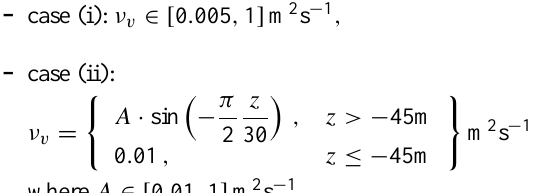
FIG. 2: Time series of the vertical velocity component w at the four indicated (inset in panel b) near-shore midpoints at 30 m depth in the homogeneous rectangular basin of constant depth subject to constant wind from West. Results were obtained with three different vertical eddy viscosities ν v . N denotes the number of Chebyshev polynomials needed to achieve stable and convergent numerical computations.